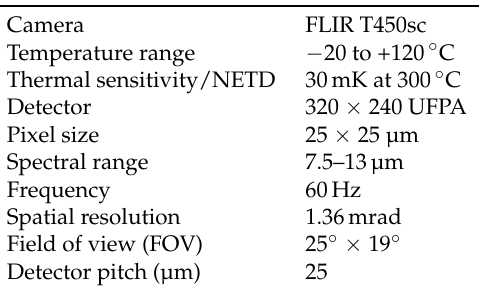
Table 2. Technical specifications of the infrared camera FLIR T450sc used in the